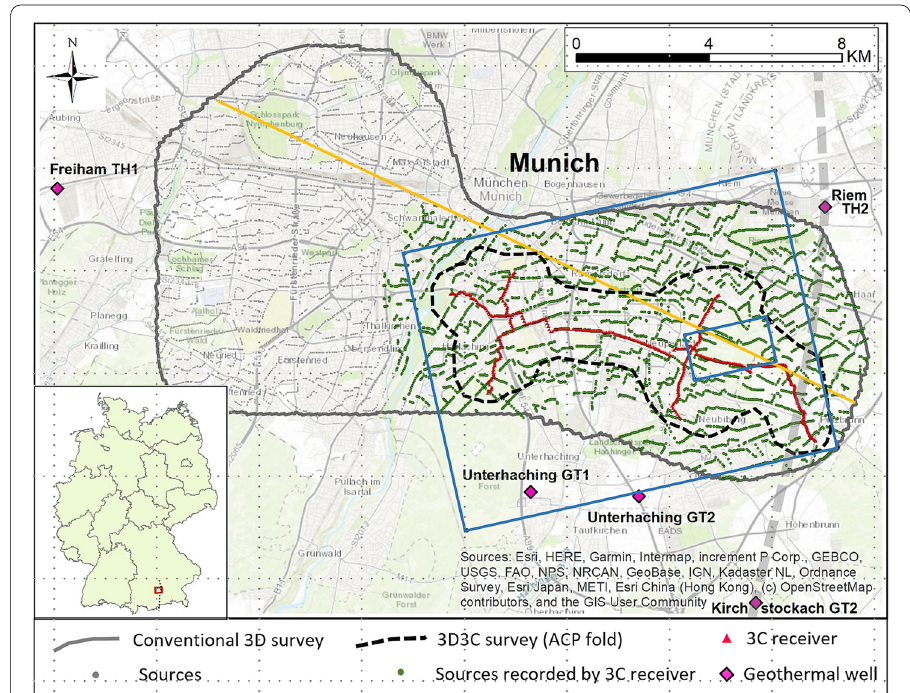
Fig. 1 Overview map of seismic measurements in the Greater Munich area. The 3D P-wave conventional survey was carried out in the southern and western part of Munich and accompanied by S-wave experiments. The eastern half of the shots (green dots) was also recorded by 3C receivers (red dots). The black dashed line marks the part of the 3D volume covered by S-wave information. The thick dashed grey line gives the position of the geological section shown in Fig. 2a, the yellow line gives the position of the seismic section shown in Fig. 2b. The large blue rectangle outlines the 3D cube used for PS processing (inlines 1–230, from WSW to ENE; crosslines 1–172, from SSE to NNW). The small blue rectangle marks the area of the v P /v S analysis in the Upper Jurassic unit (Figs.